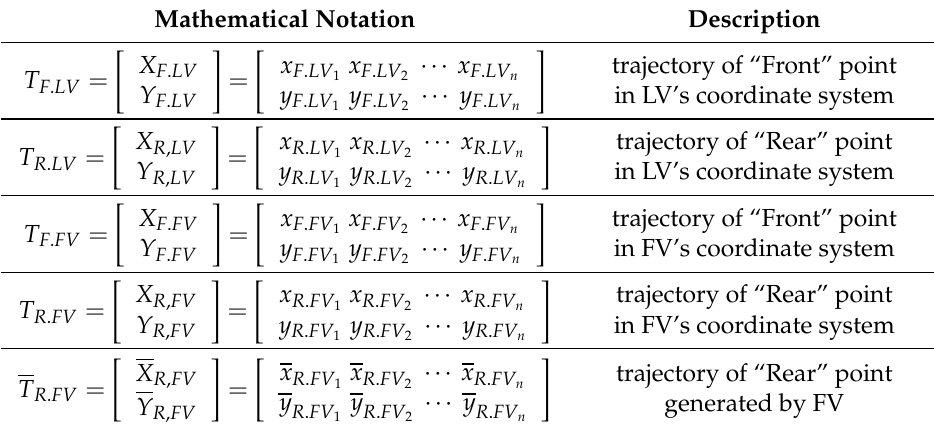
Table 2. Trajectories involved in path